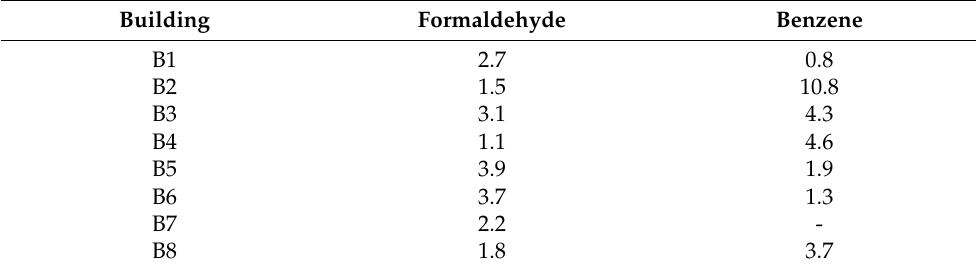
Table 6. HQ values in all buildings under investigation for formaldehyde and benzene.